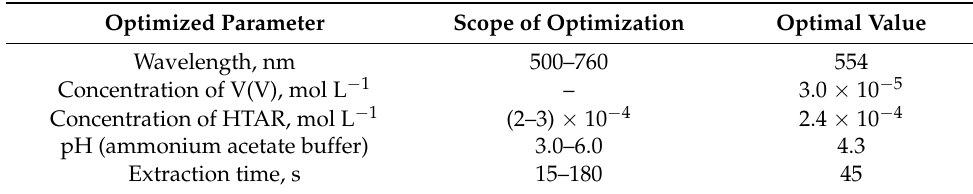
Figure 10. Reoptimized Str. 2 at the BLYP/6-31G level of theory. Visualization using the Chemcraft graphical program (https://chemcraftprog.com (accessed on 1 February 2023)). Table 3. Extraction–spectrophotometric